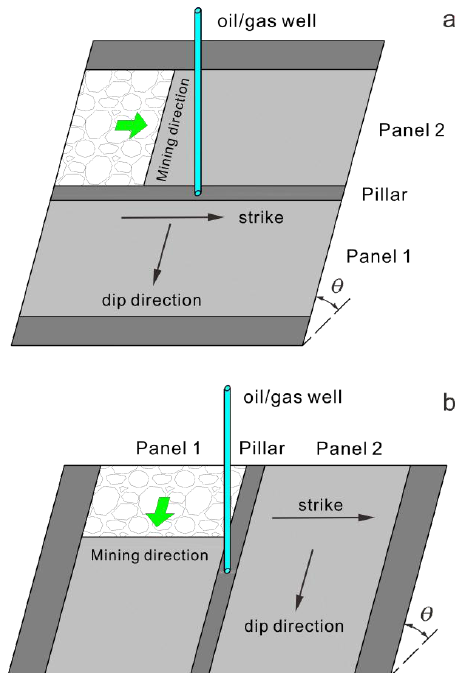
Figure 11. Layout of longwall panels along strike ( a ) and dip direction ( b ) within an inclined coal seam.